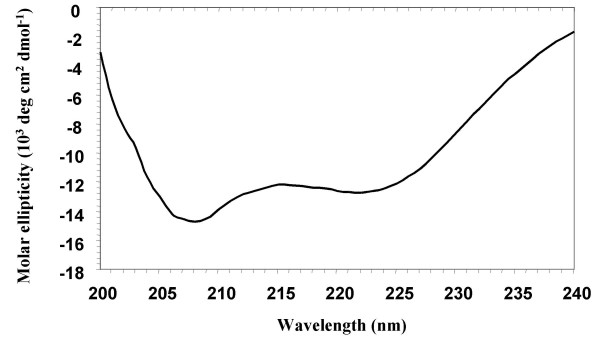
Evaluation of SSO0551 secondary structure elements by circular dichroïsm. The molar ellipticity was calculated on the basis of exact amino acid composition of SSO0551 recombinant product.